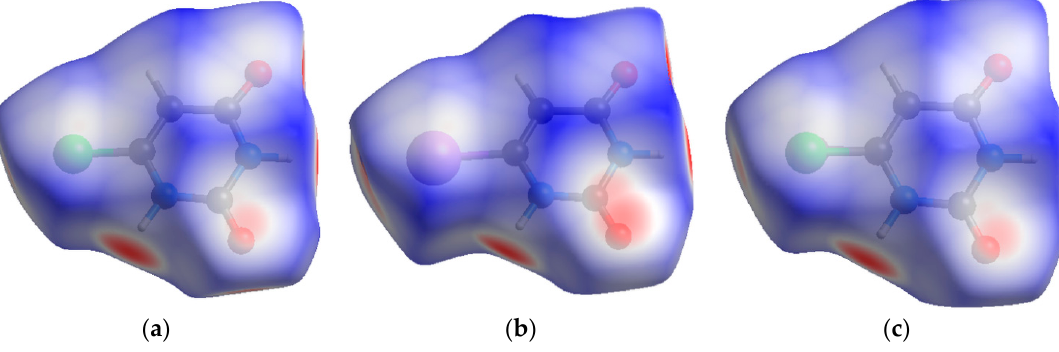
Figure 7. Hirshfeld surfaces mapped on d norm . ( a ) 6Clura; color scale: − 0.583 (red) − 1.024 a.u. (blue). ( b ) 6Iura; color scale: − 0.614 (red) − 1.091 a.u. (blue). ( c ) 6Cl6Mura; color scale: − 0.609 (red) − 1.115 a.u. (blue).